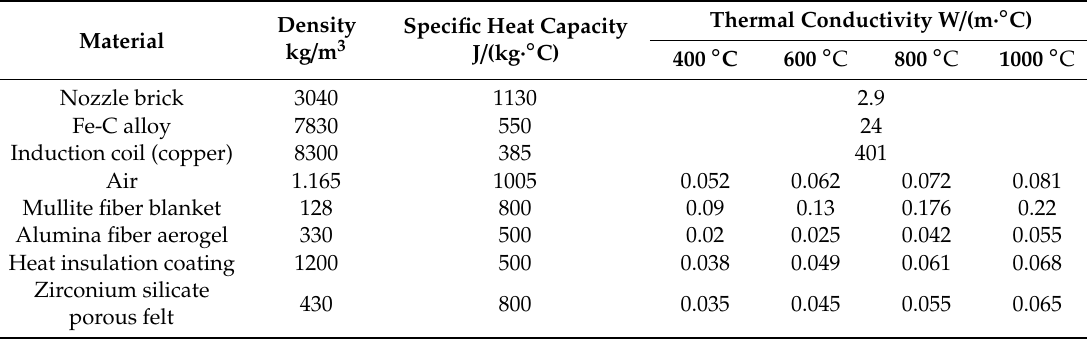
Table 2. Physical parameters of several